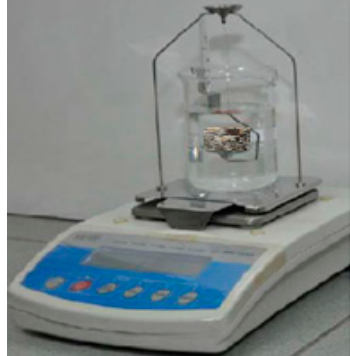
Figure 2. Density measurement by means of the hydrostatic method.